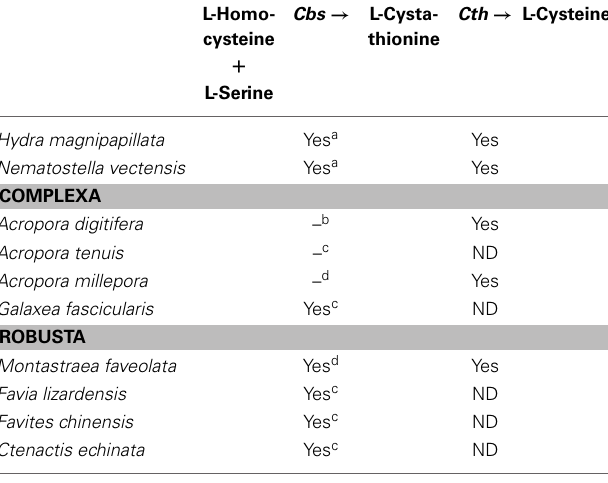
Table 3 | The presence or absence of a gene encoding cystathionine β -synthase (Cbs) for L-cysteine biosynthesis in